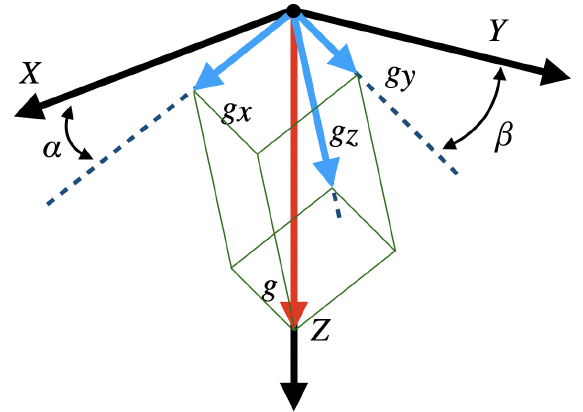
Figure 2. Axes accelerations and Euler